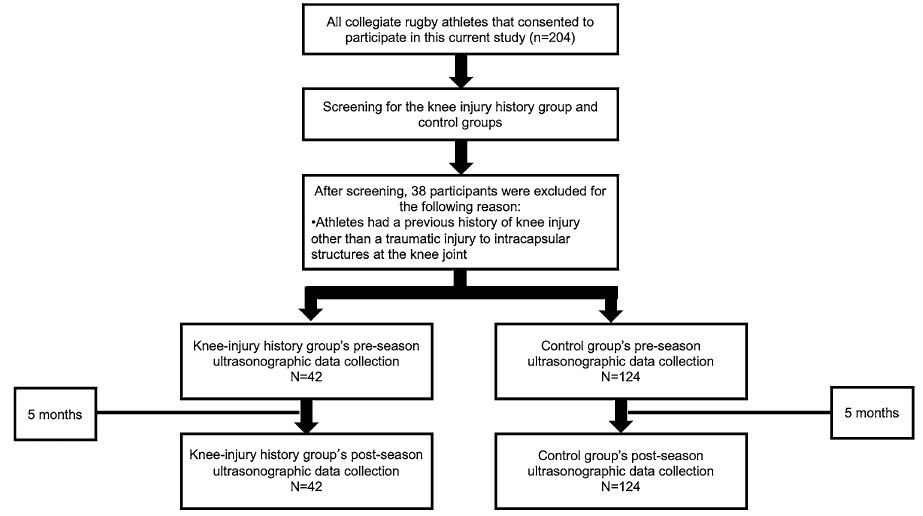
Figure 1. Flow chart depicting rugby player participation, data loss, and time between femoral cartilage ultrasonography outcome measures data collection